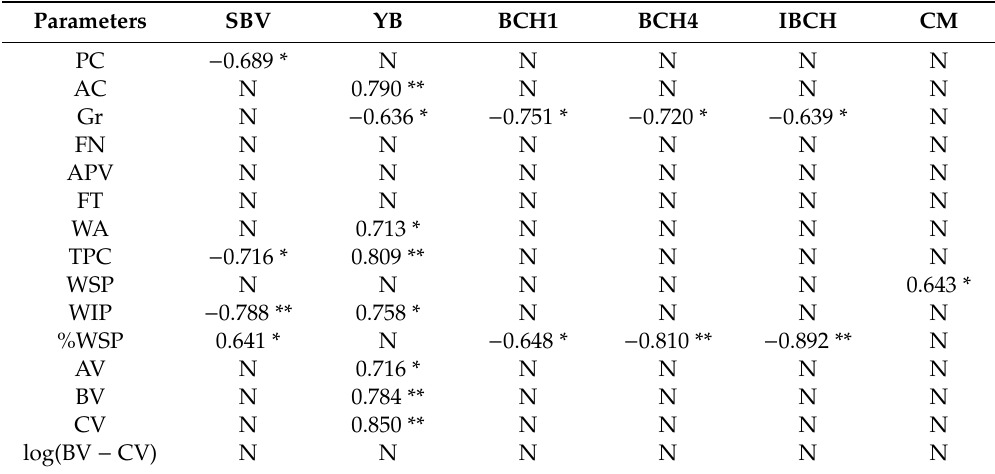
Table 5. Correlation coe ffi cients between the rye flour and bread properties. Parameters